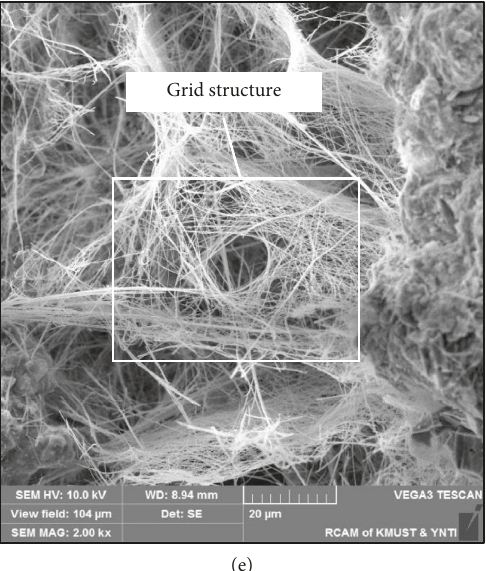
Figure 9: The microstructure image of cement soil sample specimen enlarged by 2000 times. (a) 5% cement ratio. (b) 10% cement ratio. (c) 15% cement ratio. (d) 20% cement ratio. (e) 25% cement